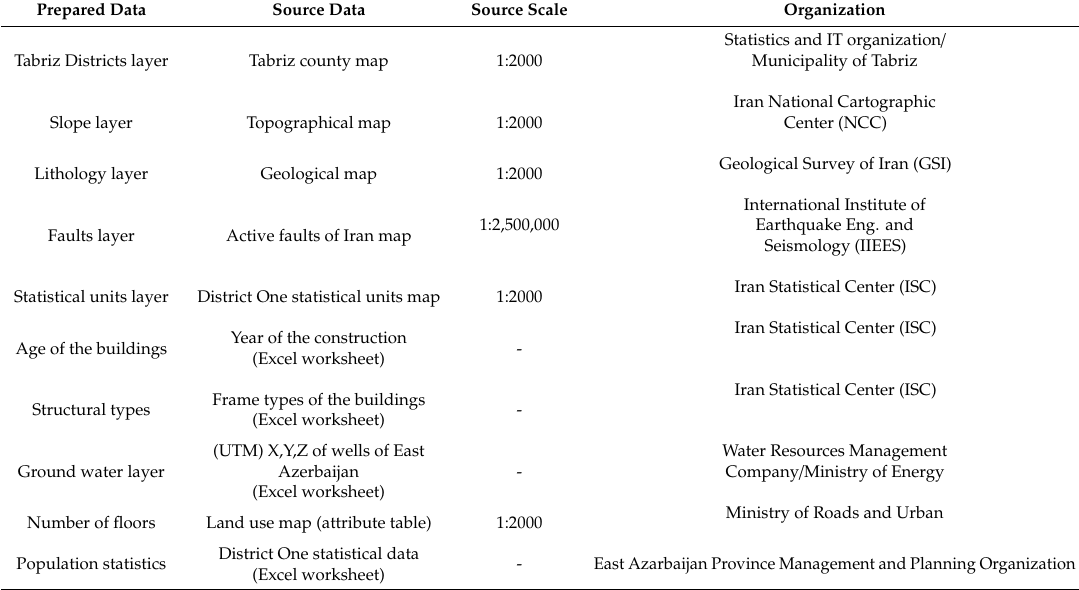
Table 1. The used data and the providing organizations.